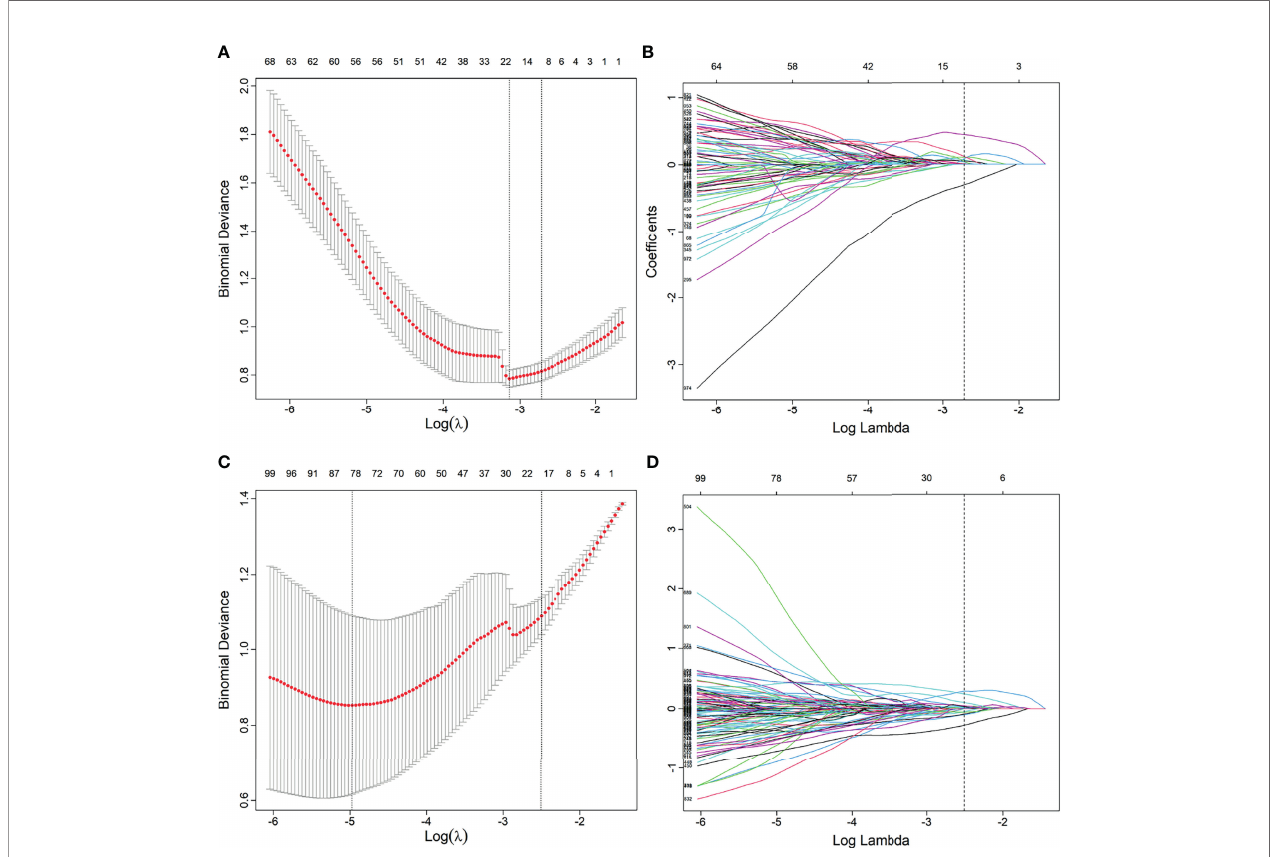
FIGURE 2 | Feature selection using the least absolute shrinkage and selection operator (LASSO) regression model. (A, B) Feature selection in LASSO without synthetic minority oversampling technique (SMOTE) method. (C, D) Feature selection in LASSO with SMOTE method. (A, C) Tuning parameters ( l ) in the LASSO model used 10-fold cross-validation via minimum criteria. The partial likelihood deviance was plotted versus log ( l ). Dotted vertical lines were drawn at the optimal values by using the minimum criteria and the 1 standard error of the minimum criteria (the 1 − SE criteria). (B, D) Feature coef fi cients corresponding to different l values in the LASSO model. Vertical line (optimal l ) was drawn at the value selected using 10-fold